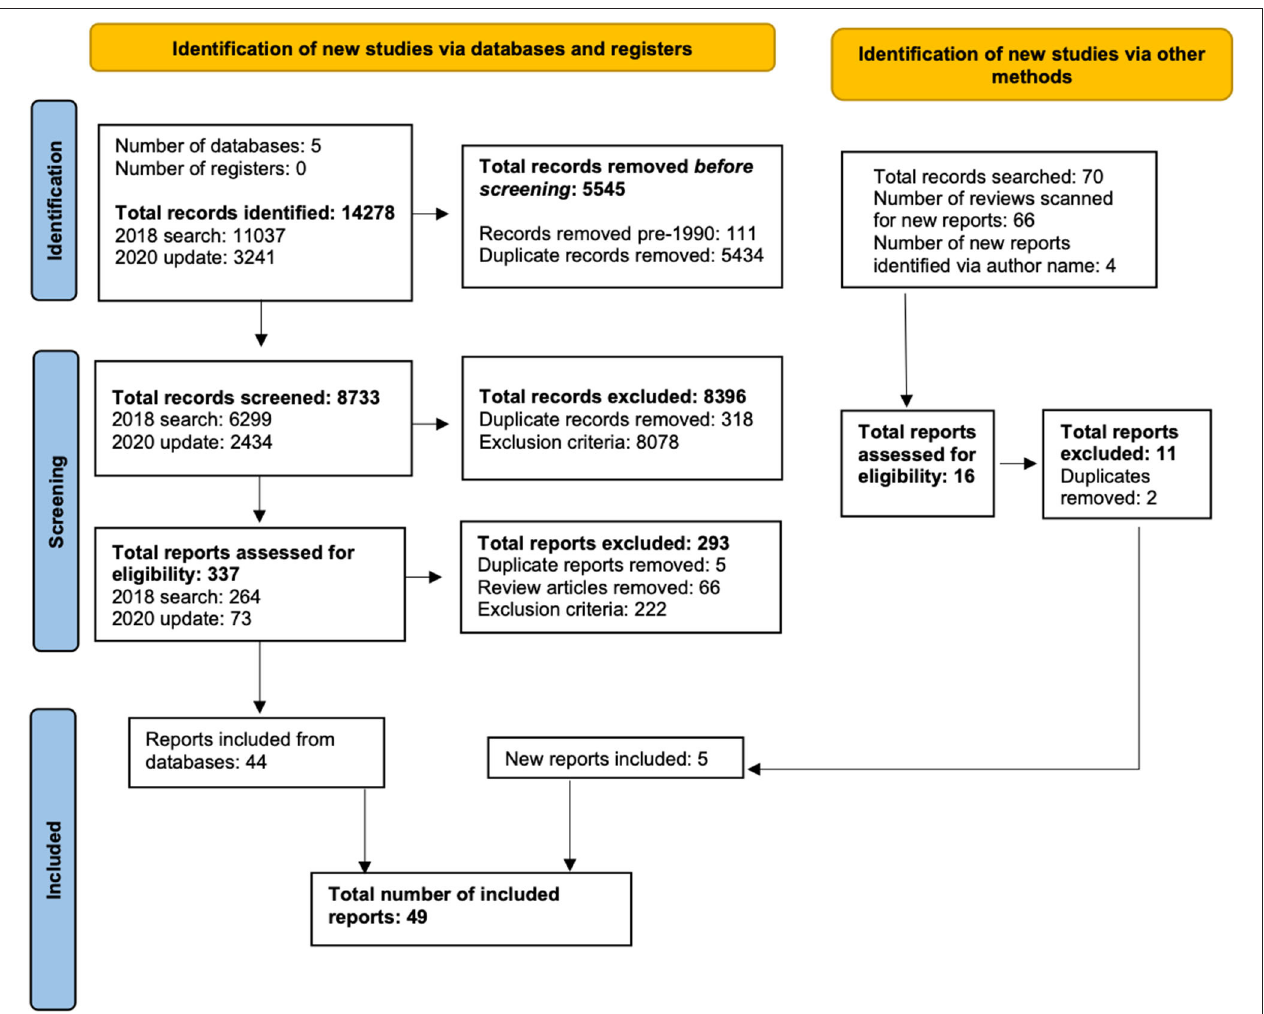
FIGURE 1 | PRISMA 2020 flow diagram for updated systematic reviews which included searches of databases, registers, and other sources.